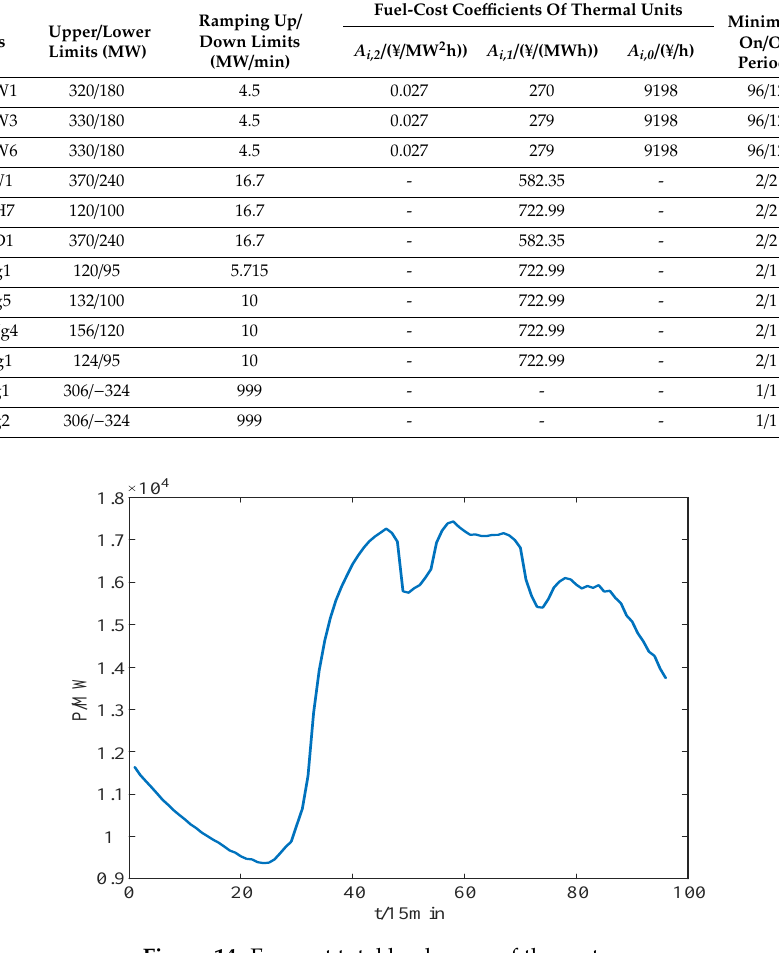
Figure 14. Forecast total load curve of the system.